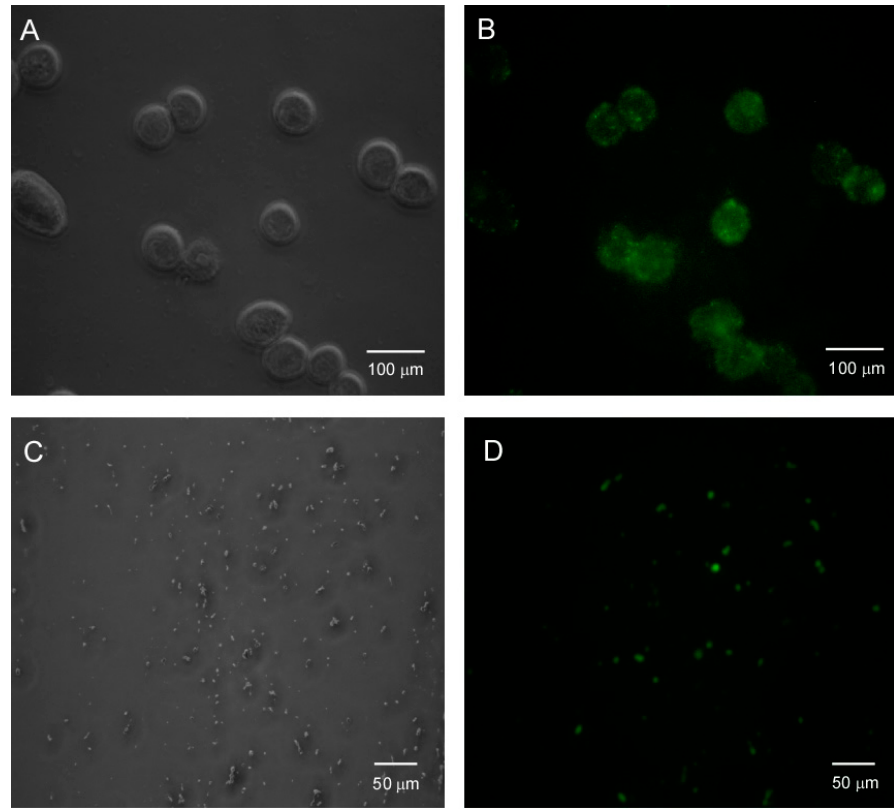
Figure 8. Microscopy images of human HeLa cells ( A , B ) and bacteria E. coli ( C , D ) in presence of HTMA-PFBT, observed by contrast phase ( A , C ) and upon excitation with Vis-light using the FITR filter set ( B , D ).